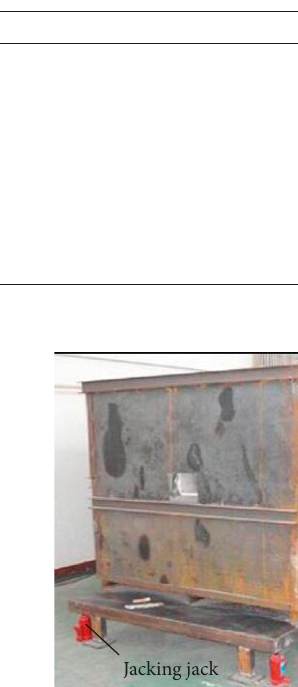
Table 2: Test grouping.